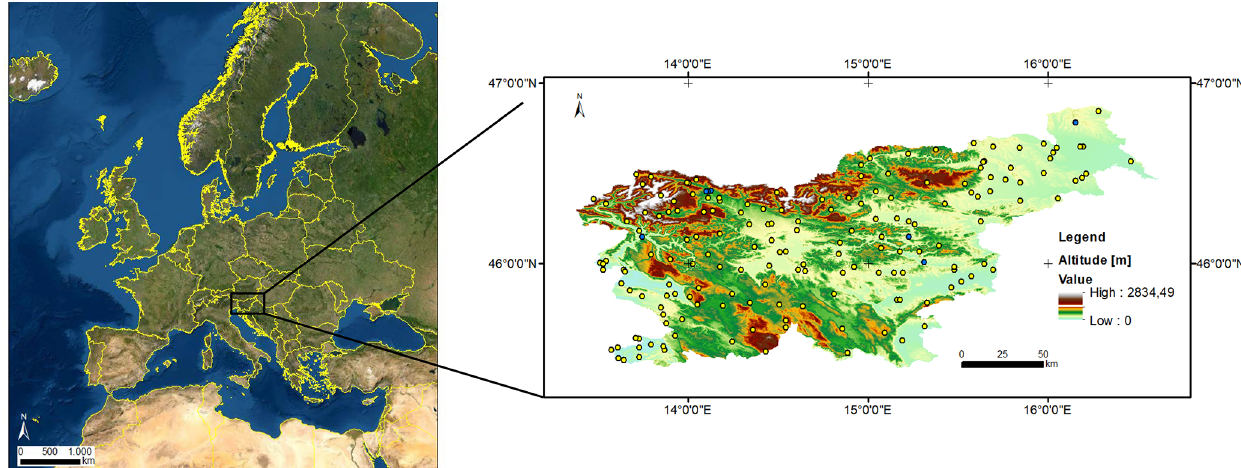
Figure 1. Location of Slovenia in Europe (left) and spatial distribution (right) of the 174 meteorological stations with temperature and precipitation information (yellow dots) and only precipitation (blue dots) (Esri, 2020; GISCO, 2020; GURS,